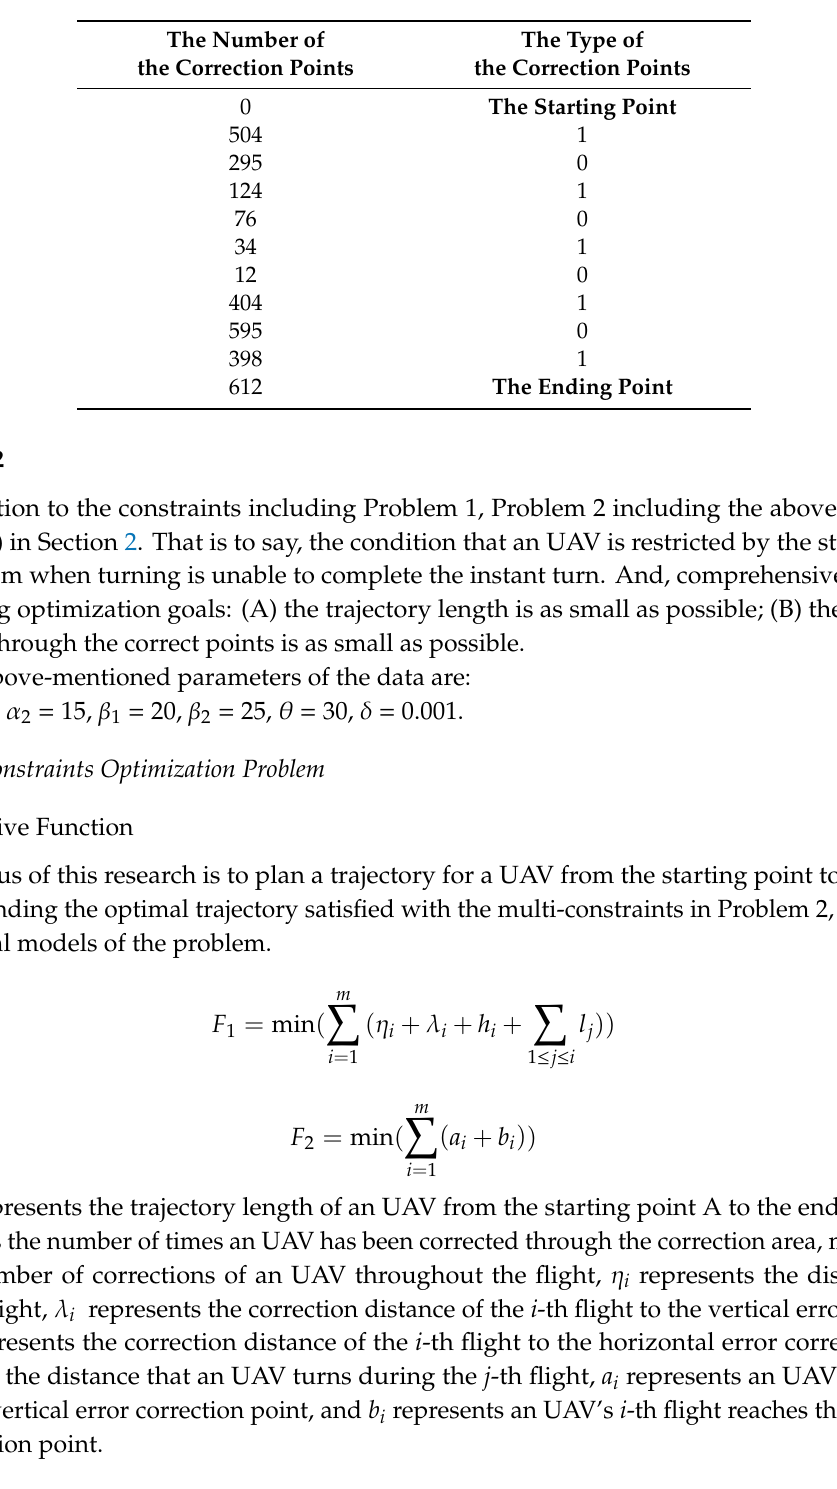
Table 2. Corrects result for Problem